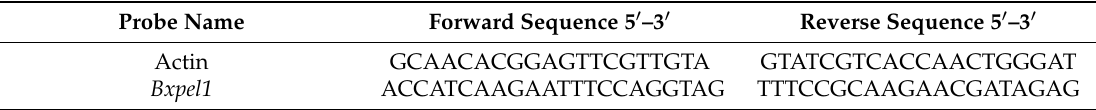
Table 3. Primers used for quantitative real-time PCR (qRT-PCR)